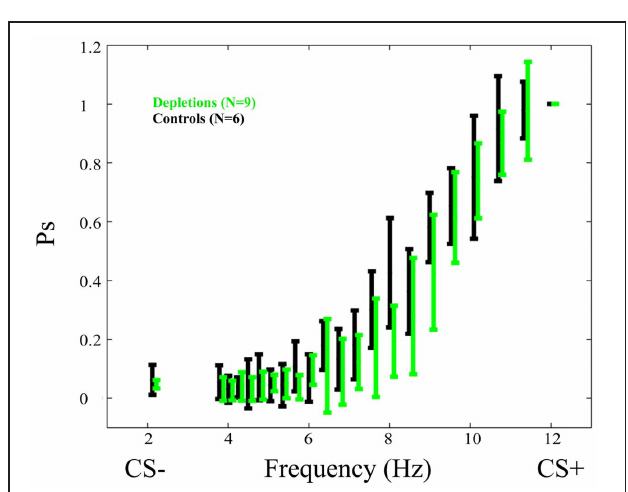
demonstrating lighter staining. Note that both sections were processed as part of the same assay, in the same plate, with the same stop time.